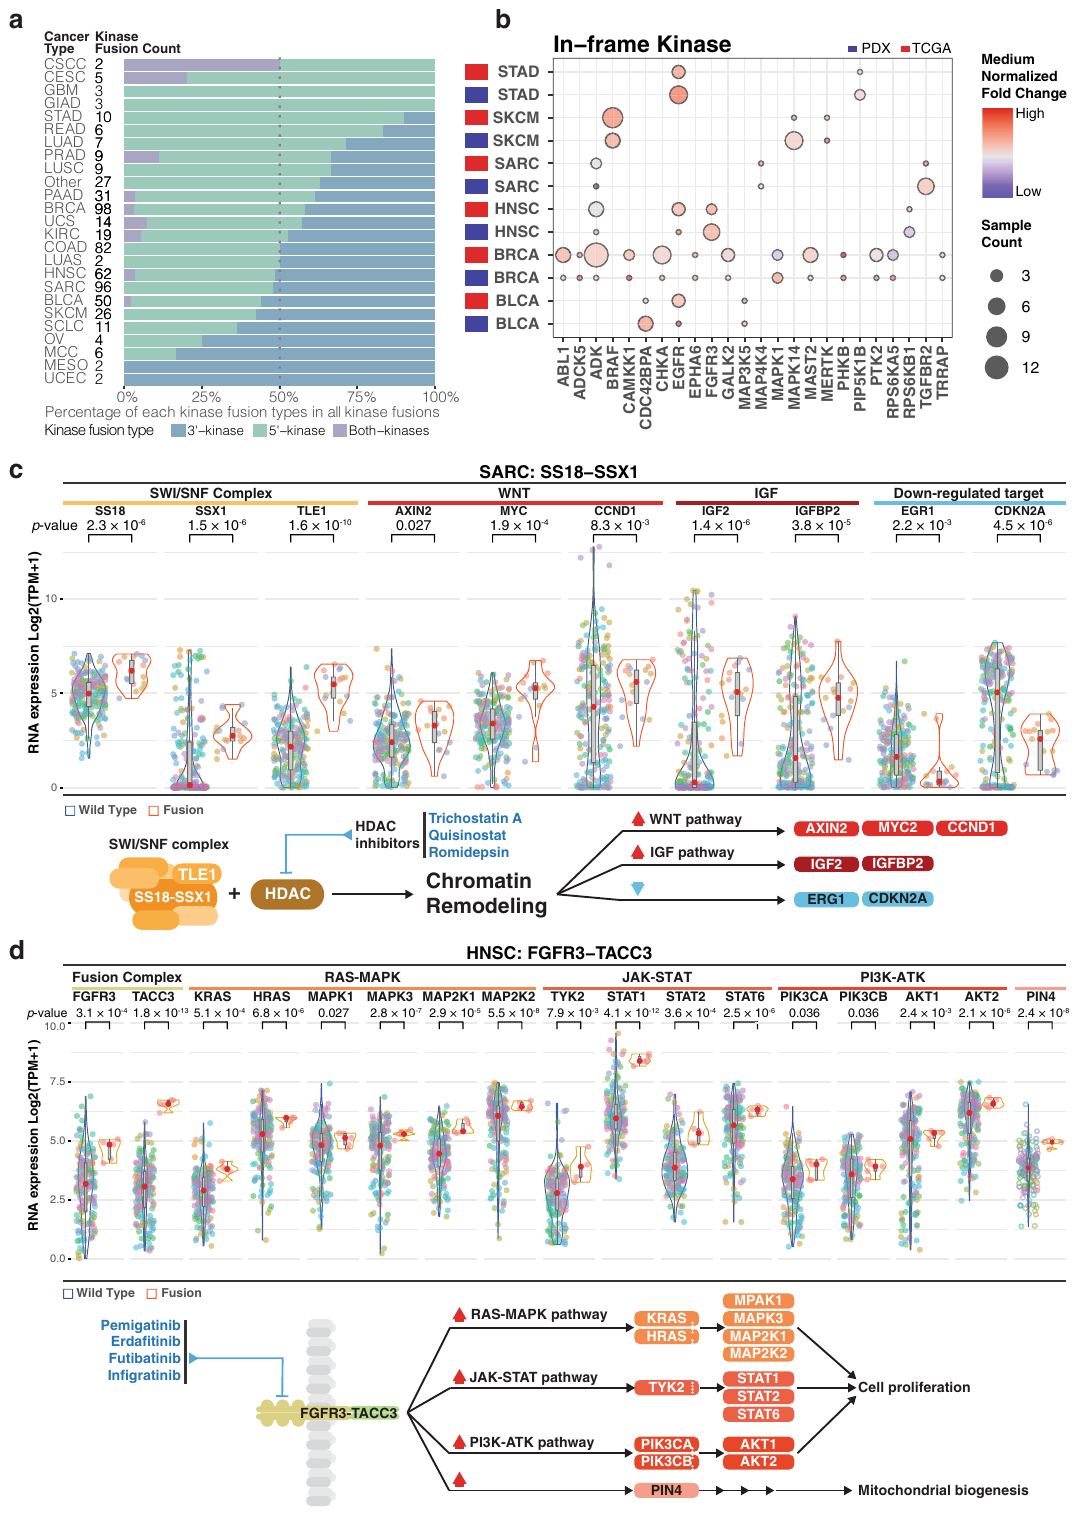
pemigatinib, futibatinib, and in fi igratinib for testing treatment ef fi cacy. These HNSC PDX models are also eligible for NCI- MATCH trial arm K2 testing the FGFR inhibitor erda fi tnib. These examples showcase PDX models suitable for further treatment studies and how downstream pathways could be used as reporters for evaluating treatment ef fi